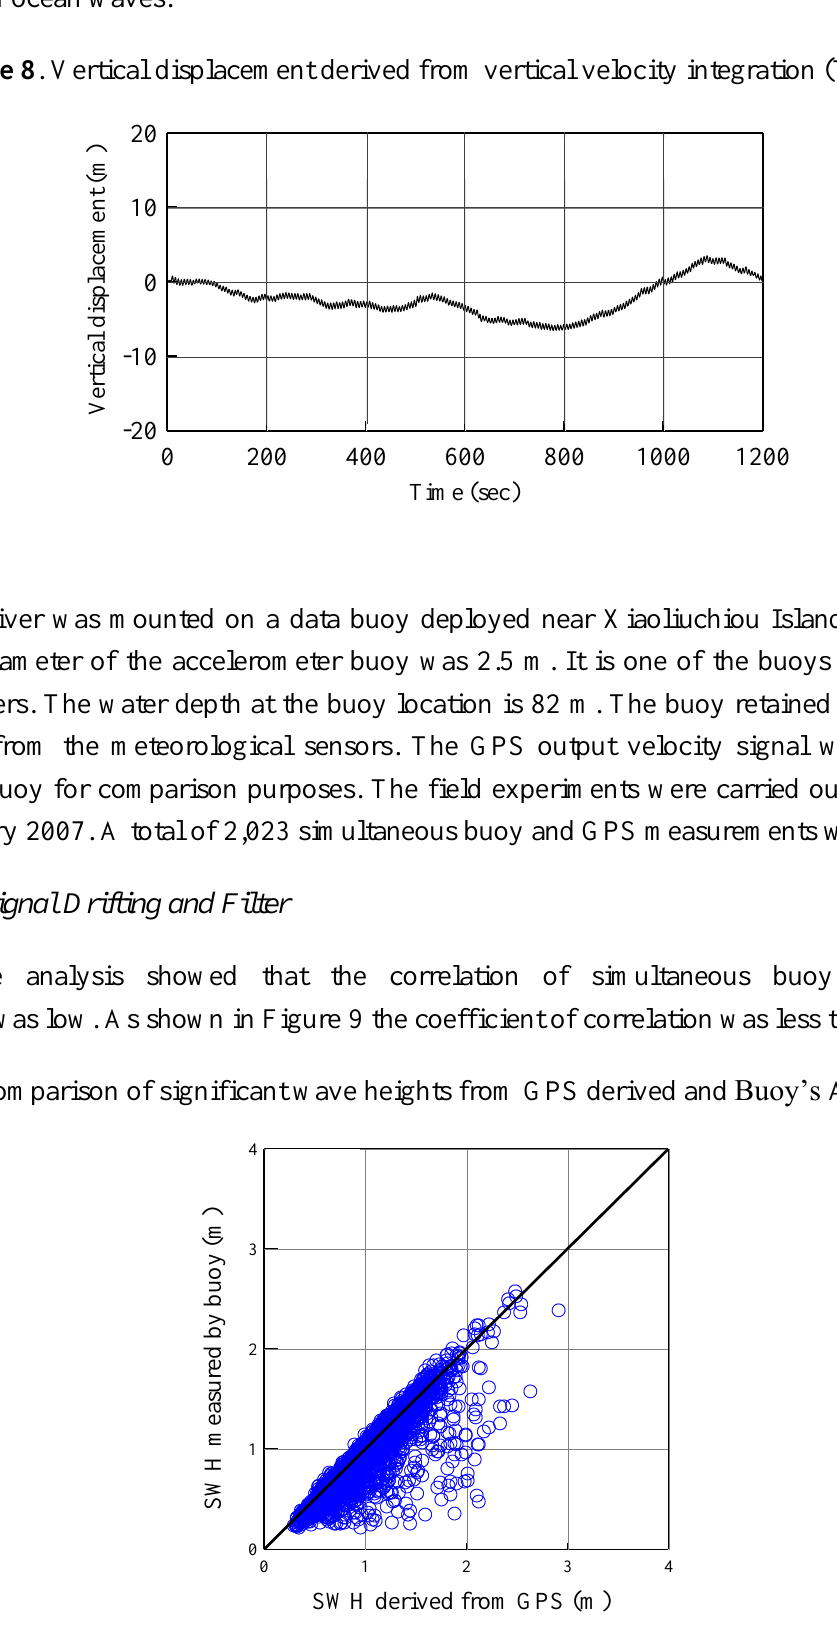
SWH derived from GPS